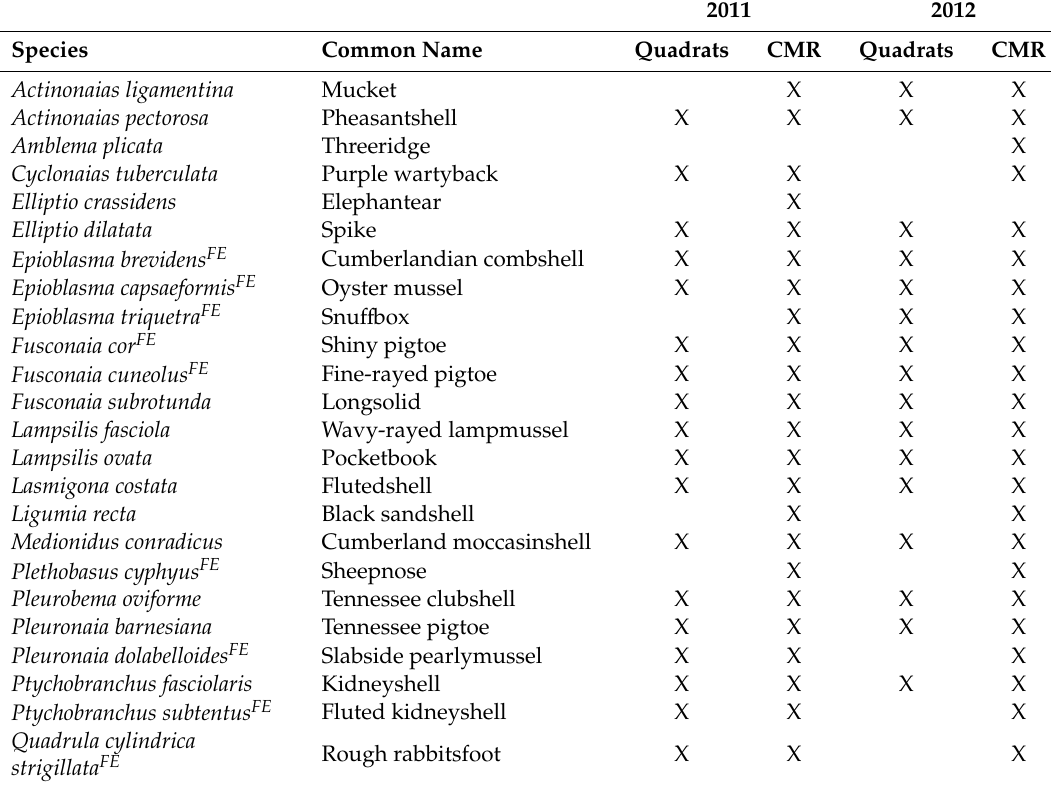
Table A3. Species collected at Cleveland Islands (furthest left-descending channel) in the Upper Clinch River, Russel County, Virginia, using systematic quadrat (with multiple random starts) and capture-mark-recapture (CMR) sampling approaches in 2011 and 2012.